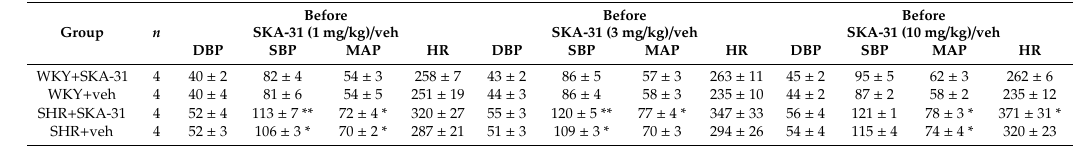
Mean ± SEM; * p < 0.05, ** p < 0.01 compared to respective WKY group. n represents the number of